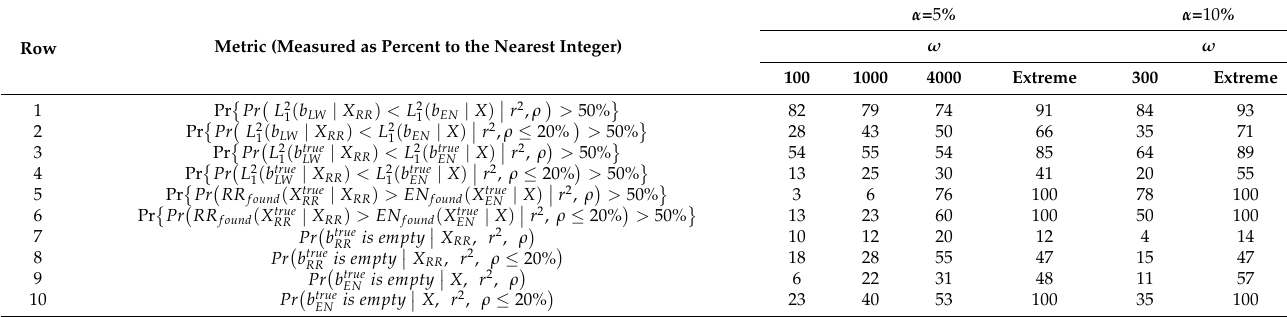
Table 8. RR vs. EN by ω at α settings of 5% and